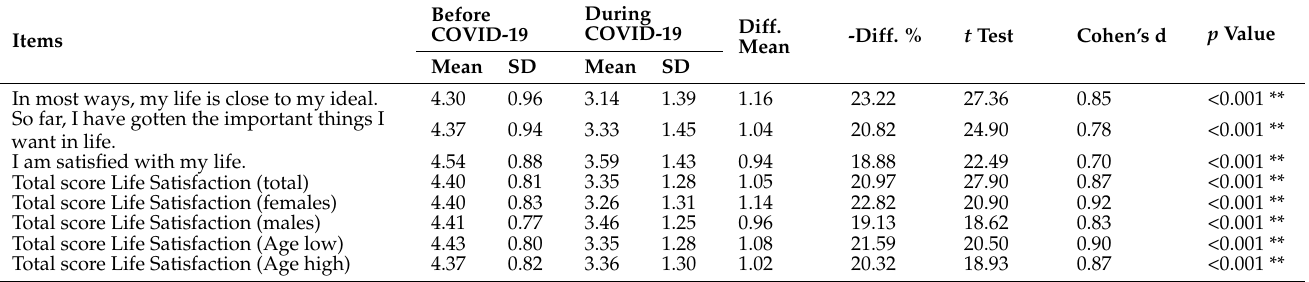
Table 4. Responses to the Short Life Satisfaction Questionnaire-Lockdowns (SLSQL) before and during the COVID-19